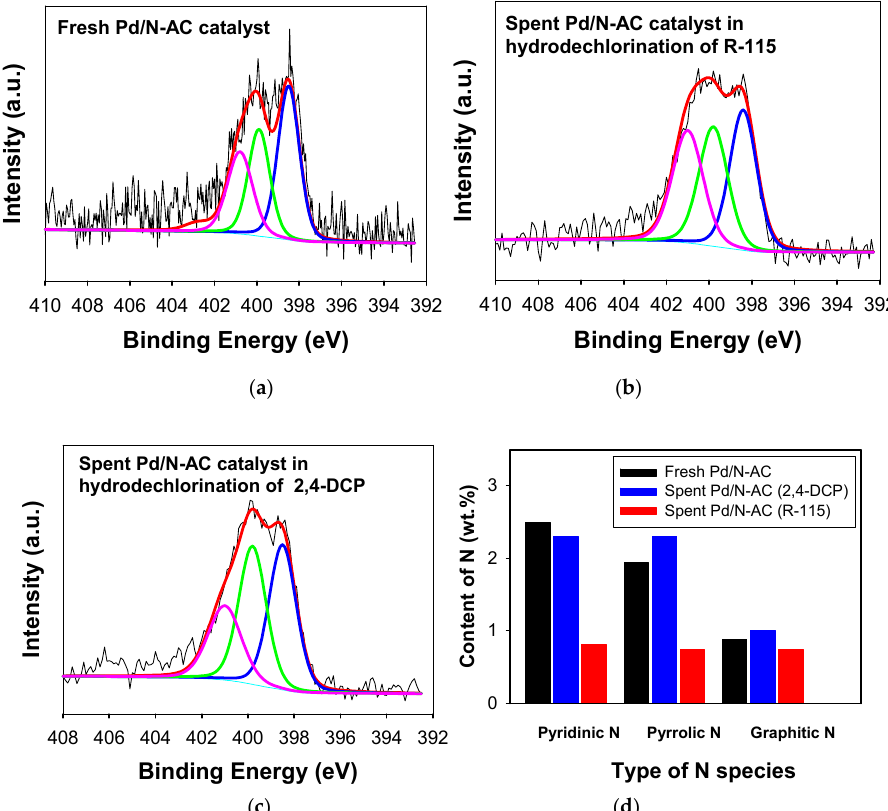
Figure 1. N1s XPS spectra ( a–c ) and the content of N of different types ( d ) of fresh Pd/N-AC catalyst and spent Pd/N-AC catalysts in hydrodechlorination of R-115 and 2,4-DCP. The raw data are shown by the black curve, and the fitting curve is indicated by the red curve. The decomposed peaks are presented by the blue (pyridinic N), green (pyrrolic N), and purple curves (graphitic N).